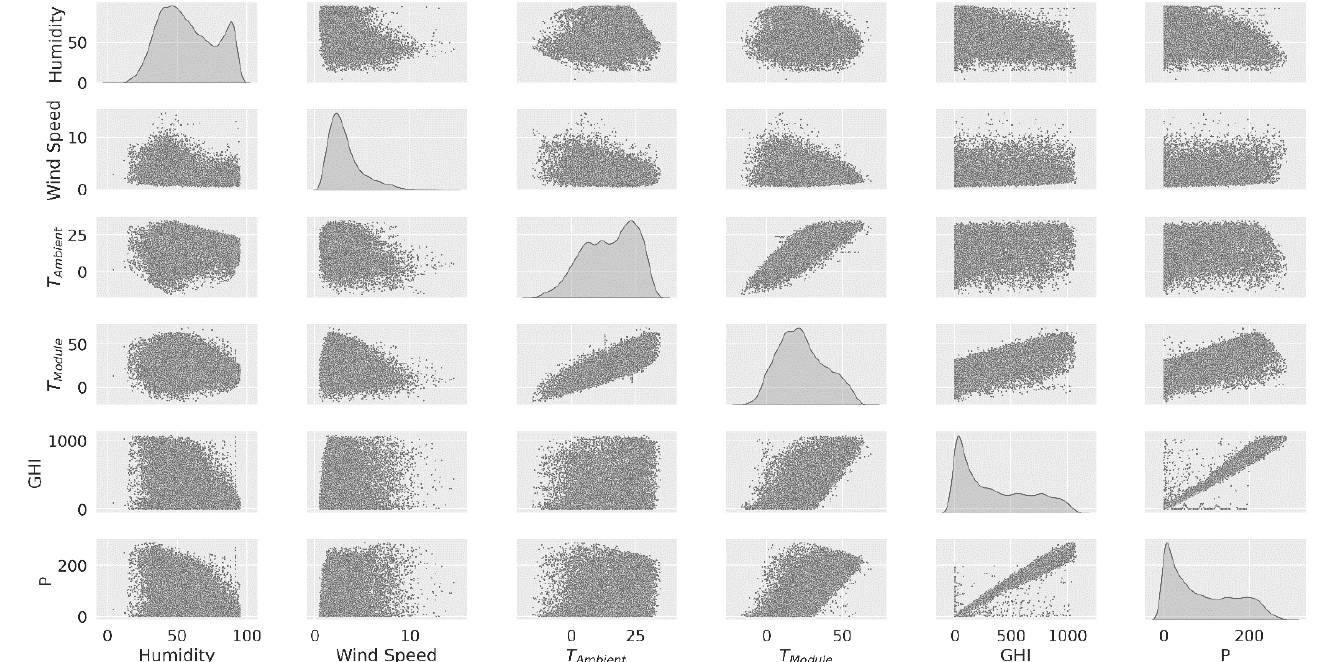
Figure 5. Pairwise plot of NIST data set